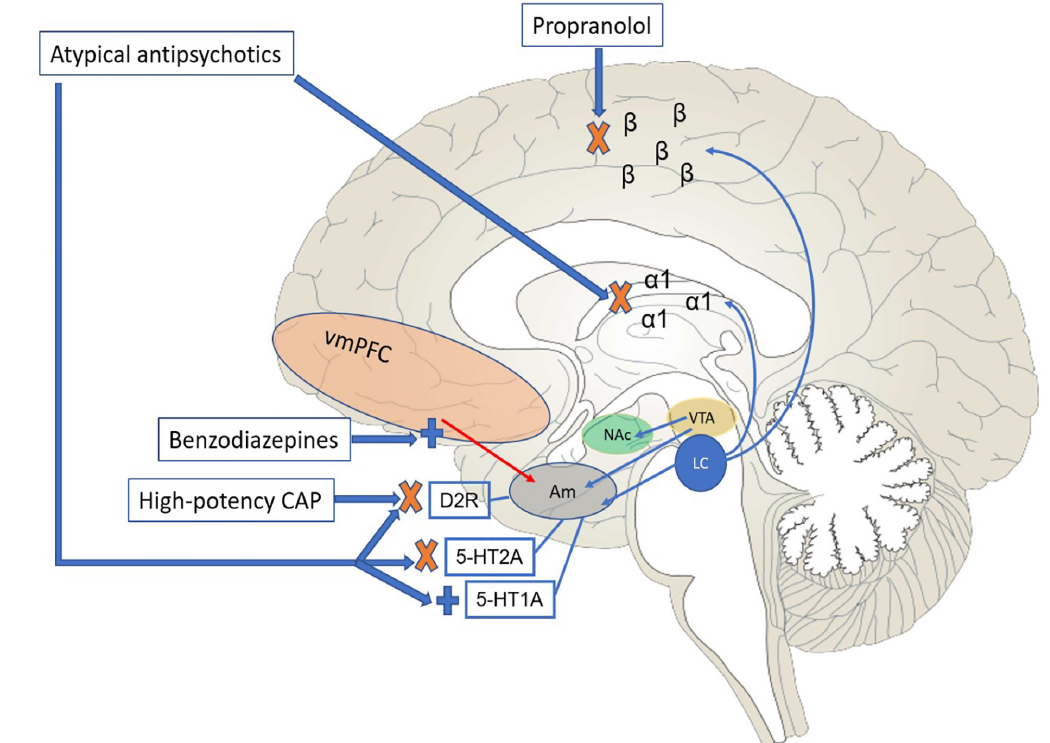
Figure 1. Schematic depiction of medial surface of cortex, subcortical areas, and brainstem, demonstrating key neural circuitry linked with the mechanisms of action of drugs used for the treatment of acute agitation. In states of heightened catecholaminergic tone, such as stimulant intoxication, acute psychosis, or mania, there may be excessive dopamine availability, binding amygdala D2 receptors and increasing conditioned fear responses. In addition, noradrenergic input from the locus coeruleus may also be elevated, contributing to autonomic arousal and feelings of paranoia. As levels increase, binding of norepinephrine will be shifted from the prefrontal cortex (PFC) to posterior cortical and subcortical regions (indicated by β and α1 receptors – schematically depicted for didactic simplicity), decreasing the individual’s ability to cognitively negotiate the situation at hand, particularly as PFC-amygdala coupling is diminished. Medications used for agitation can mitigate the effects of this neurotransmitter and circuitry make-up through the following mechanisms: 1) benzodiazepines, through GABA-A agonism, increase the PFC inhibitory control over the amygdala; 2) beta-blockers (e.g., propranolol, an agent with considerable lipophilicity), in addition to their peripheral effect on autonomic arousal, can decrease norepinephrine binding to posterior adrenoreceptors, thus allowing for greater PFC binding; (3) conventional, or typical antipsychotics, particularly the high-potency agents (e.g., haloperidol), work primarily through D2 receptor blockade – this occurs within the striatum, but also in the amygdala, decreasing threat perception; 4) atypical antipsychotics have a complex mechanism of action – a) D2 blockade occurs, though therapeutic occupancy is less than required with typical agents, b) several act as α1 receptor antagonists, decreasing subcortical adrenoreceptor binding, c) through subcortical serotonergic modulation, anxiolysis is promoted – several atypicals (e.g., clozapine, ziprasidone, lurasidone, quetiapine, and aripiprazole) agonize the Gi-linked (inhibitory) 5-HT1A receptor and all atypicals antagonize the Gq-linked (excitatory) 5-HT2A receptor, thus diminishing amygdala activation. Am, amygdala; CAP, conventional (first-generation) antipsychotic; D2R, dopamine 2 receptor; LC, locus coeruleus, NAc, nucleus accumbens; vmPFC, ventromedial prefrontal cortex; VTA, ventral tegmental area.